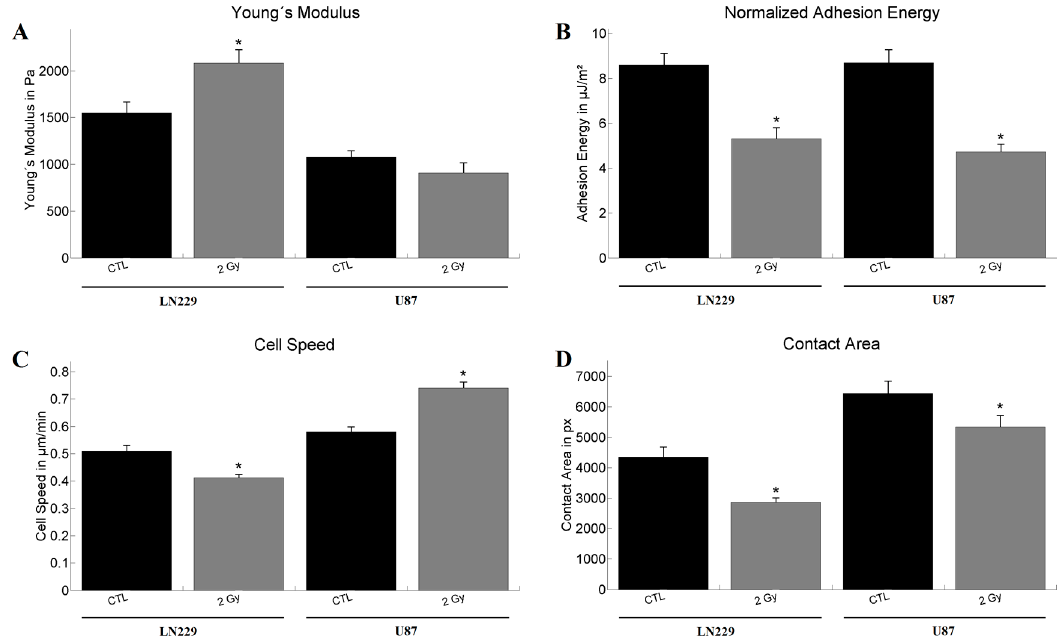
Figure 2. Results of the atomic force microscopy (AFM) and live cell imaging measurements for LN229 and U87 ( A ) Shows the Young’s modulus. Statistical significance was found after irradiation of LN229 cells ( n CTL = 60; n 2Gy = 35) only. U87 ( n CTL = 60; n 2Gy = 35) cells did not show a change in elasticity; ( B ) Calculated mean adhesion energies using the Derjarguin-Muller-Topolov model. Irradiation led to a decrease in adhesion for both cell lines. The number of analyzed cells used for determination of adhesion energy were identical to those for the Young’s modulus; ( C ) Derived speeds from the time laps images. Inverse effects could be observed for the two cell lines. LN229 reacted with a decrease ( n CTL = 118; n 2Gy = 247), while irradiation of U87 led to an increase in cell speed ( n CTL = 158; n 2Gy = 118); ( D ) Regarding the contact area of the cells after irradiation both cell lines reacted with a decrease in area. The numbers of experimental values for the cell area were identical to the ones for the cell speed. The graphs show the mean value together with the standard error of the mean. Statistical analysis was performed using the Mann–Whitney test and significance was chosen for p < 0.05. The asterisk denotes significant results regarding the control measurement of the same cell line.